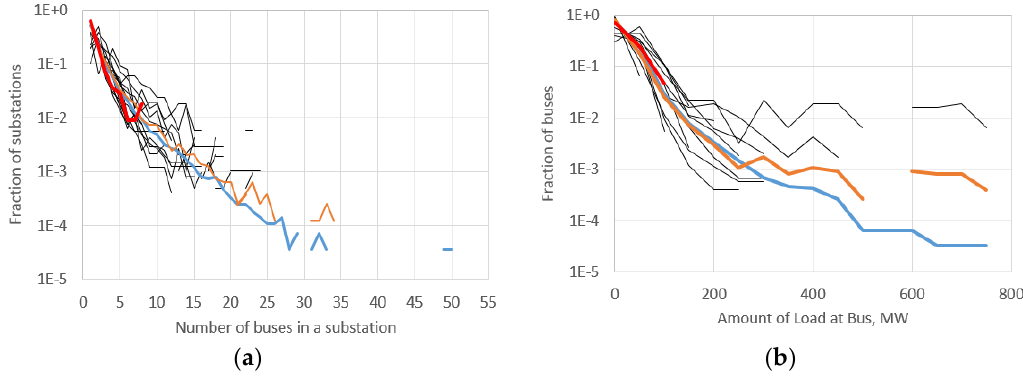
Figure 9. ACTIVSg200 validation plots. ( a ) Case distribution of buses per substation (red); ( b ) Case distribution of bus loads (red). The other lines are identical to Figures 1 and 2, respectively.